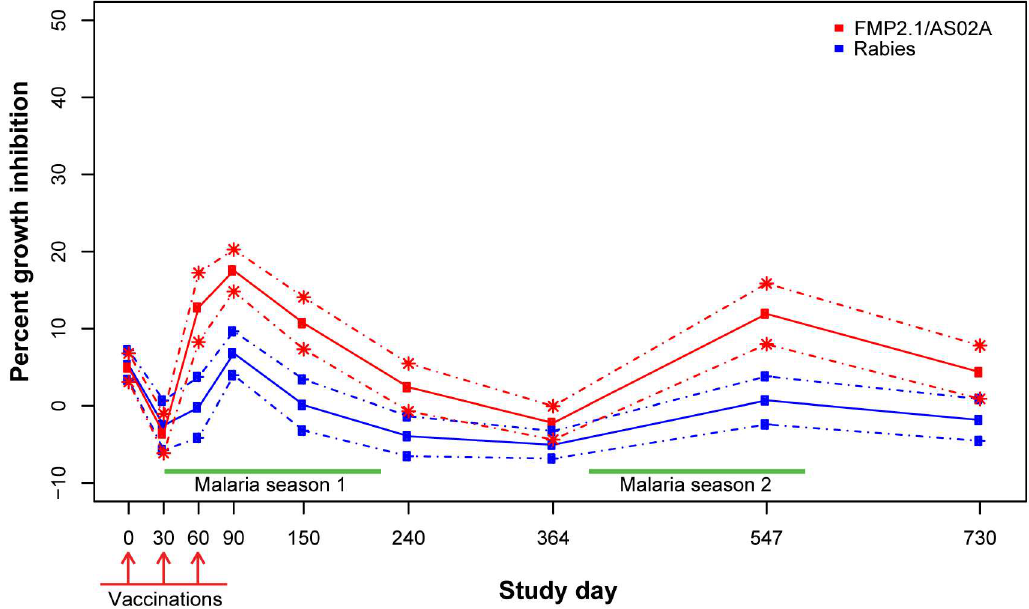
Fig 1. Mean 3D7 growth inhibition assay results by study day and group with 95% confidence